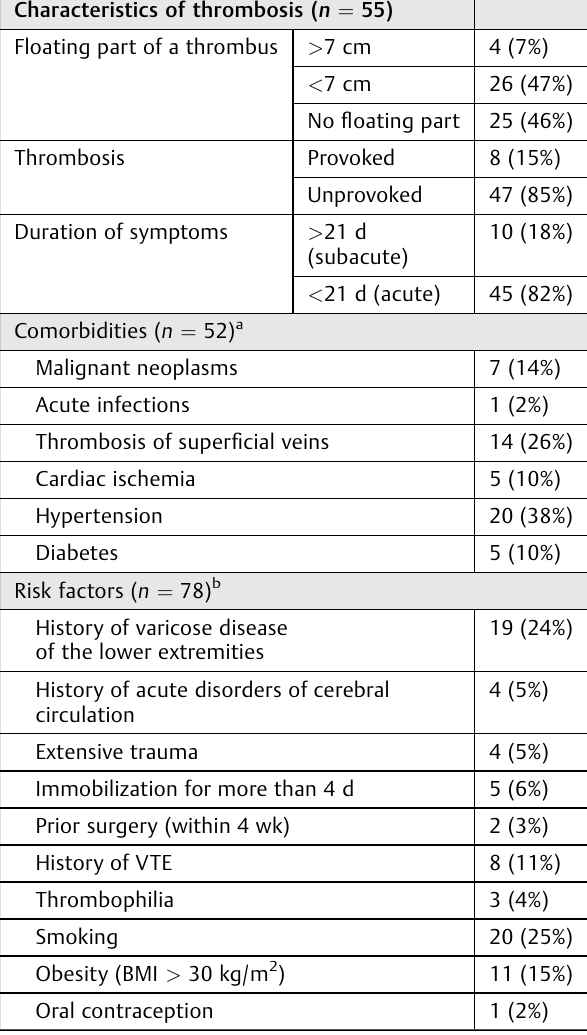
Table 1 Clinical characteristics of patients with